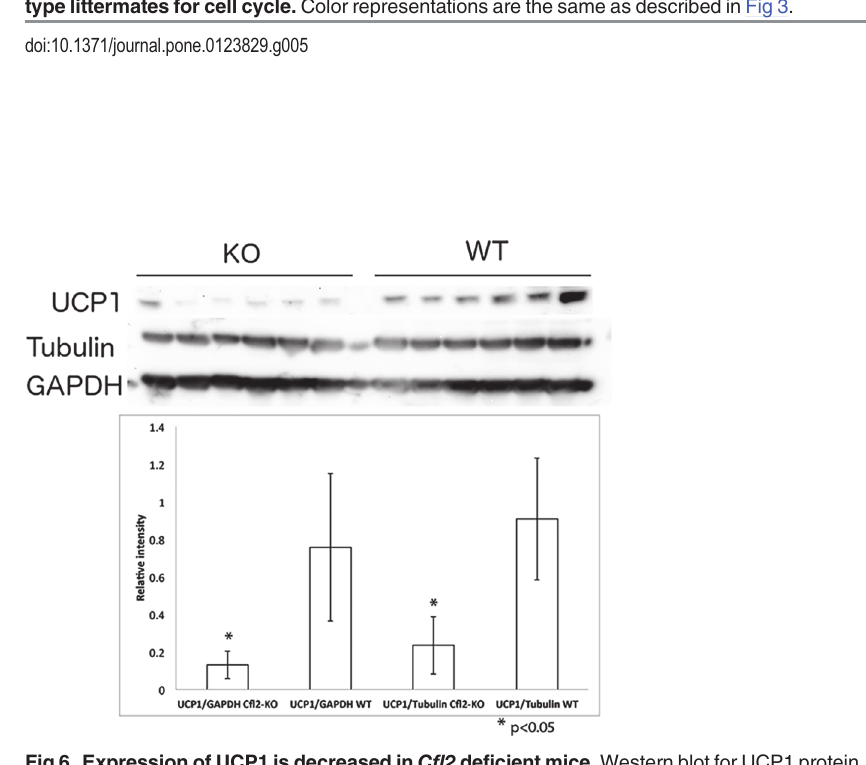
Fig 6. Expression of UCP1 is decreased in Cfl2 deficient mice. Western blot for UCP1 protein demonstrated decreased expression of UCP1 in 6 individual Cfl2 deficient mice (KO) compared to 6 individual wild-type littermates (WT). Western blot for Tubulin and GAPDH did not demonstrate any differences in expression, as a control for protein loading. Densitometry was used to demonstrate this quantitatively, with statistically significant decreases of UCP1 seen in cofilin -2 deficient mice compared to wild-type littermates when normalized to either GAPDH (left bars) or Tubulin (right bars). Asterisks indicate the p-value for difference between KO and WT mice was < 0.05 for both